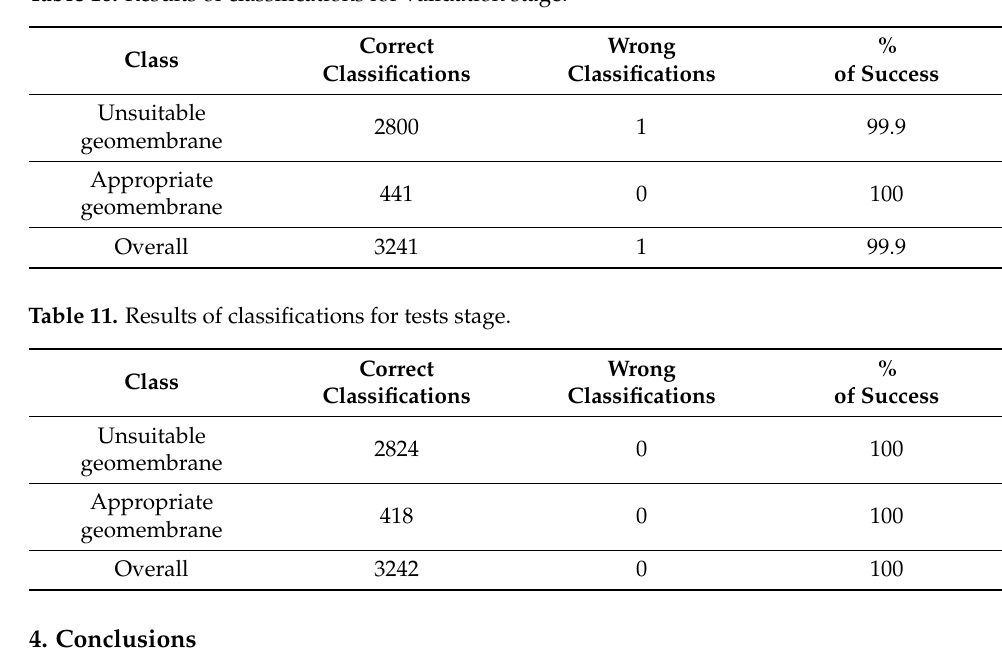
Table 10. Results of classifications for validation stage.